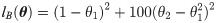
Contour lines.Plots show the contour lines of two functions, chosen to illustrate identifiable and non-identifiable cases. Plot (A) is an identifiable case illustrated by Booth function lA(θ) = (θ1+2θ2−7)2+(2θ1+θ2−5)2, which has known minimum lA(1,3) = 0. Plot (B) illustrate non-identifiable case by Rosenbrock function lB(θ)=(1−θ1)2+100(θ2−θ12)2 with minimum lB(1,1) = 0. The star-shaped points mark the minima of the above functions. The bold contour represents the CRα={θ:l(θ)−lα*≤0} for lα*=200. The dashed lines are profile paths projected on (θ1, θ2) Red circles mark the points where tangent hyperplanes correspond to parameters’ minimal or maximal values in CRα. Red circles are CI endpoints. The contours were calculated using marching squares algorithm implemented in Contour.jl package (https://github.com/JuliaGeometry/Contour.jl). They are provided for illustrative purposes only.